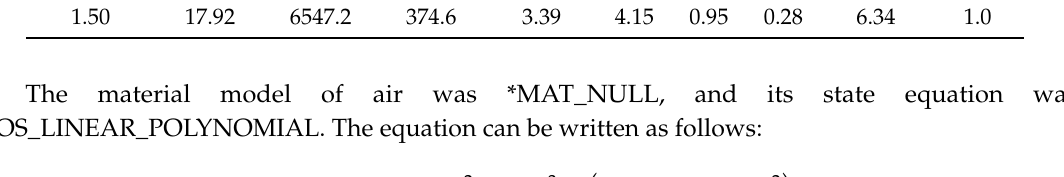
Table 1. Material model parameters and the JWL parameters of TNT.